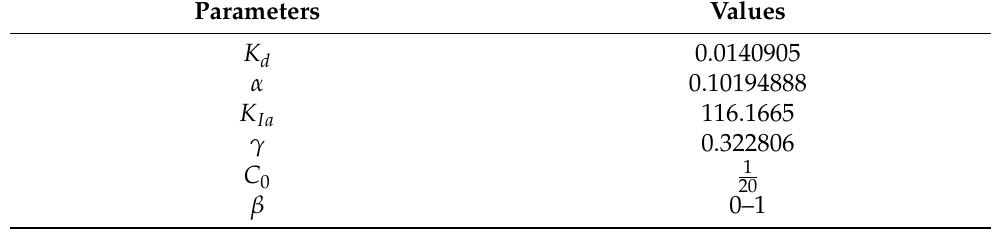
Table 2. Parameters’ values.